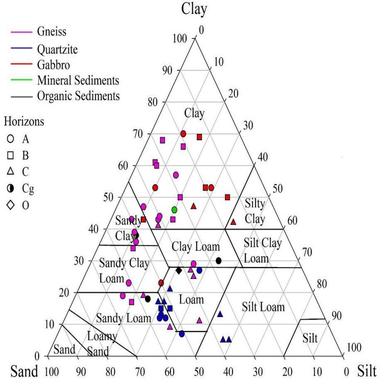
Texture of Brazilian soil samples per horizon plotted according to the USDA texture classification.